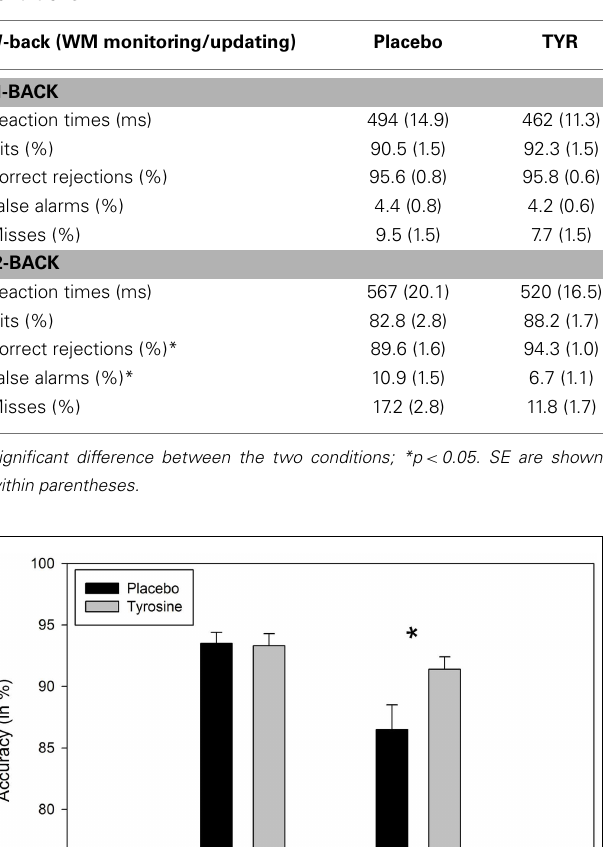
Table 1 | Mean RTs (in ms), hits, correct rejections, false alarms, and misses (in percent) for the N -back task for placebo andTYR conditions .